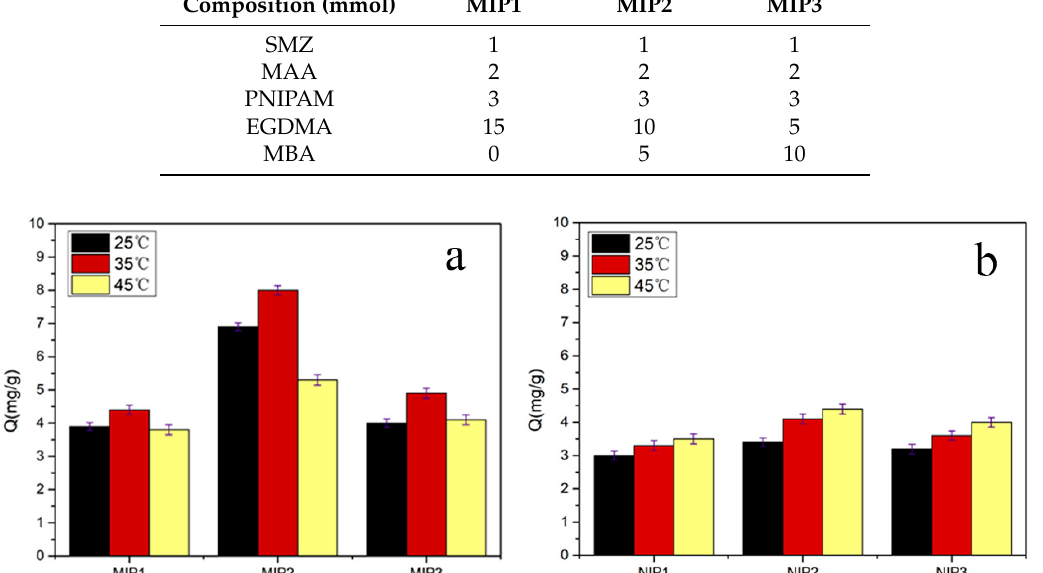
Figure 2. Adsorption capacities of three groups of MIPs ( a ) and non-imprinted polymers (NIPs) ( b ) at different temperatures (10 mg of MIPs/NIPs in 5 mL of 0.3 mmol · L − 1 sulfamethazine (SMZ) solution for 5 h). Each Q value takes the average of three measurements, and the error bars represent the SD.